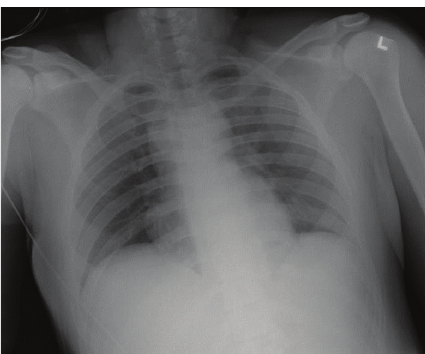
Figure 1: An AP chest X-ray in the trauma bay showed no obvious pneumothorax, hemothorax, or bullet fragment.